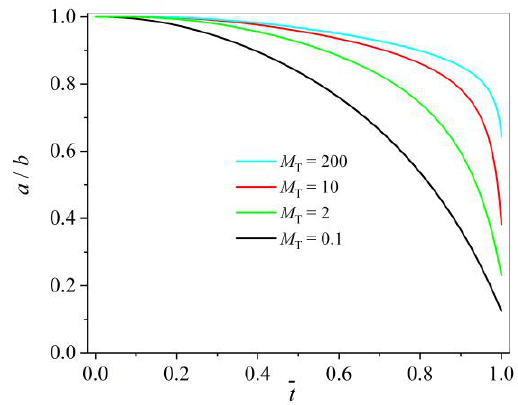
Figure 3. The a / b ratio of grain I as a function of t for di ff erent M T -values. Figure 3. The a/b ratio of grain I as a function of t for different